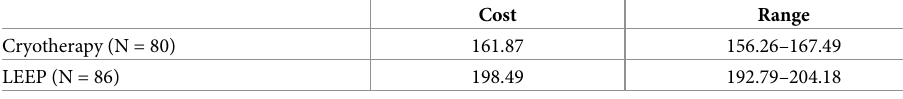
Table 7. Average cost per disease-free case (US$ 2015), as-treated analysis.